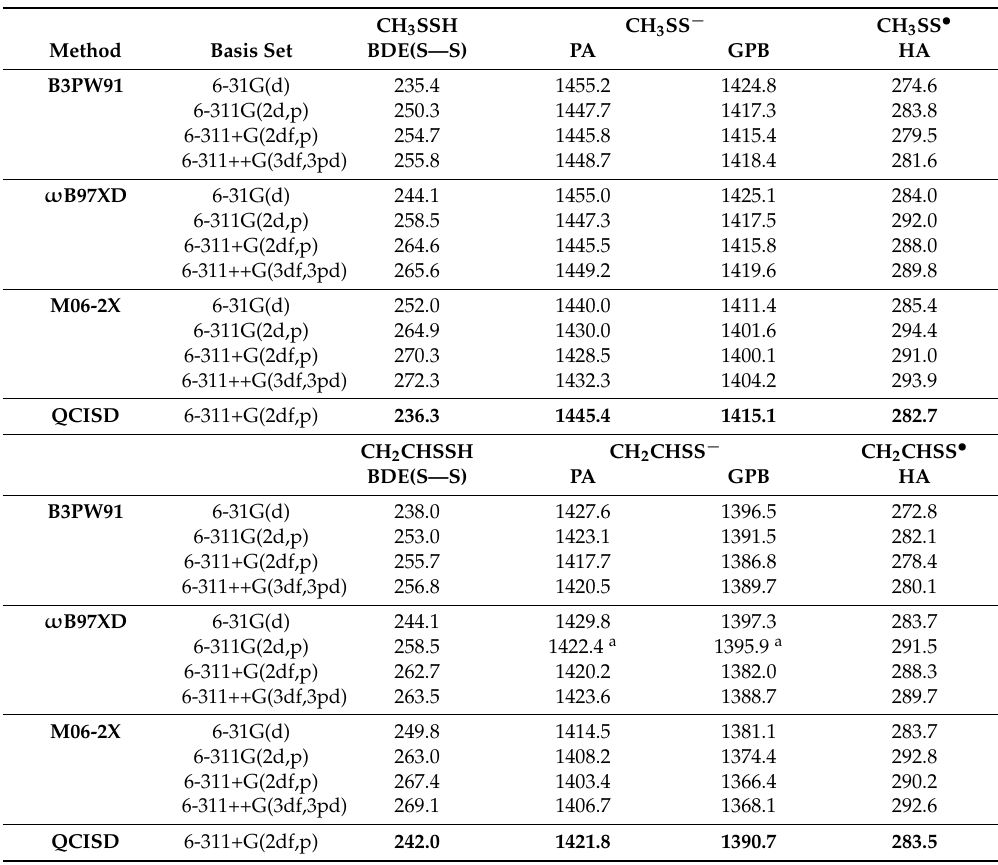
Table 5. Homolytic S − S bond dissociation enthalpy (BDE) of RSSH, proton affinity (PA) and gas-phase basicity (GPB) of RSS − , and hydrogen affinity (HA) of RSS • (R = CH 3 , CH 2 CH). All energies calculated at 298.15K and in kJ mol − 1 (see Section